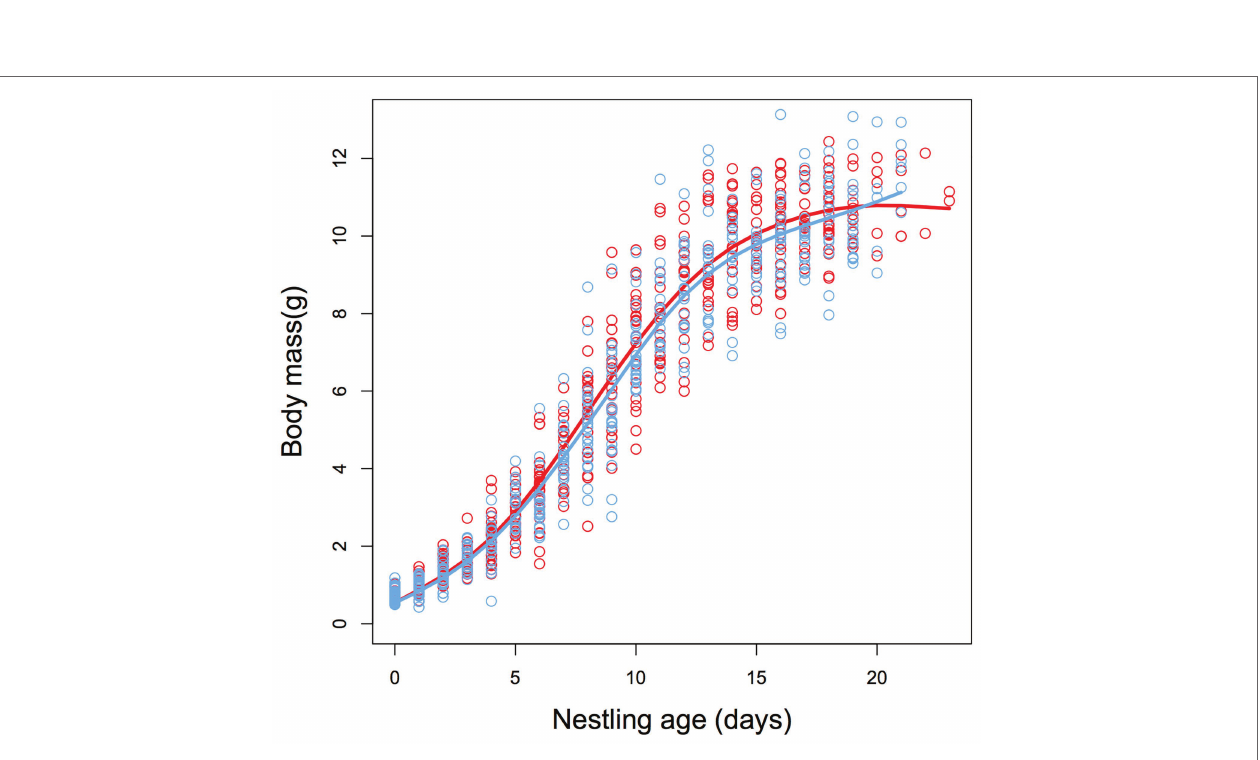
FIGURE 2 | Sigmoidal plot describing the post-natal growth trajectories for body mass of zebra finch ( T. guttata ) nestlings from control (blue) and heated (red) nests. There was no significant difference in growth rate or asymptotic body mass between treatment groups (see Results section for details). N = 11 and